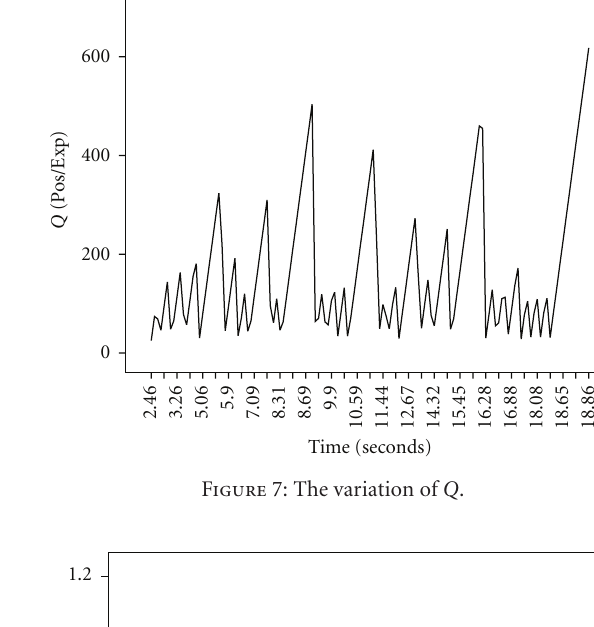
Figure 7: The variation of Q .